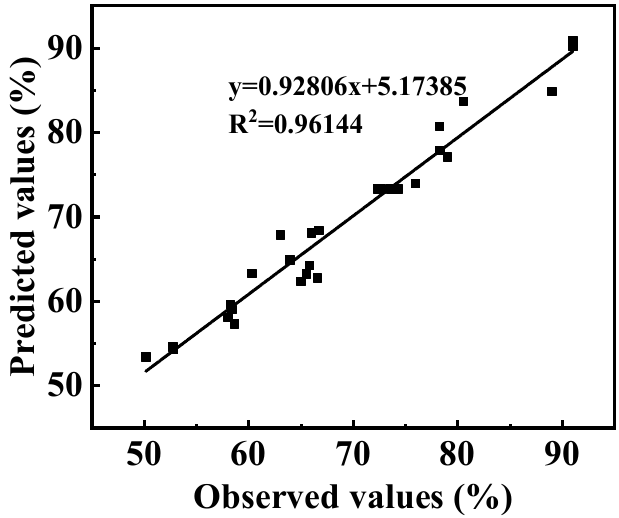
Figure 3. The predicted vs. observed plots for the leaching rate of Sn.